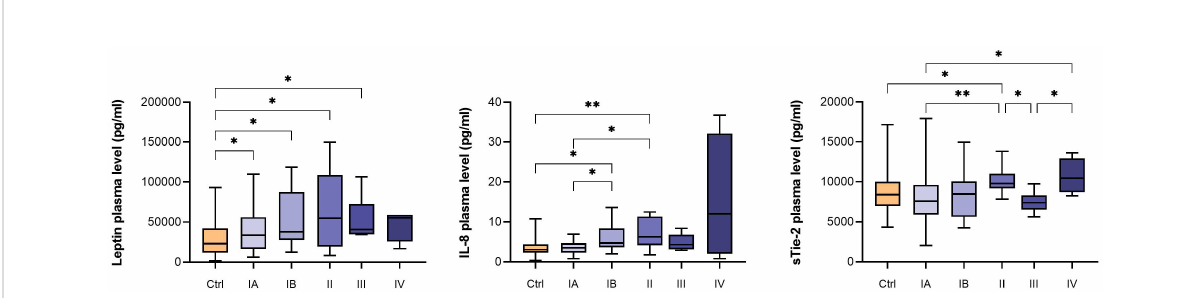
FIGURE 3 Box plots with median, minimum and maximum for plasma leptin, IL-8 and sTie-2 levels (pg/mL) for control patients and EC patients in different FIGO stages. P-values were calculated using Kruskal-Wallis tests with post hoc test without correction. *p < 0.05; **p < 0.01.